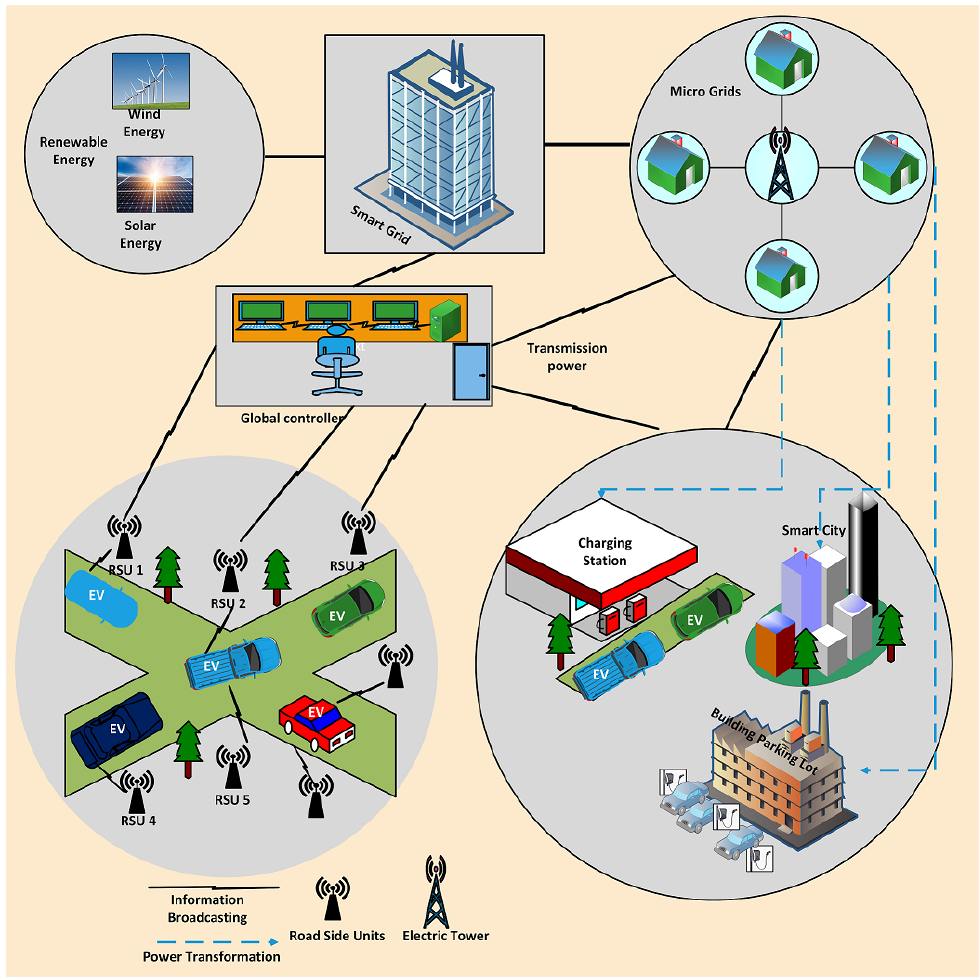
Figure 3. Communication and Service Architecture